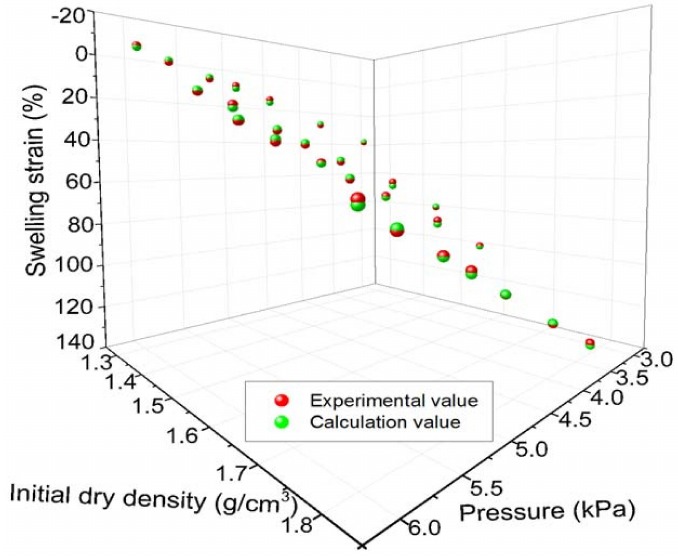
Figure 12. Comparison between calculated, and experimental,